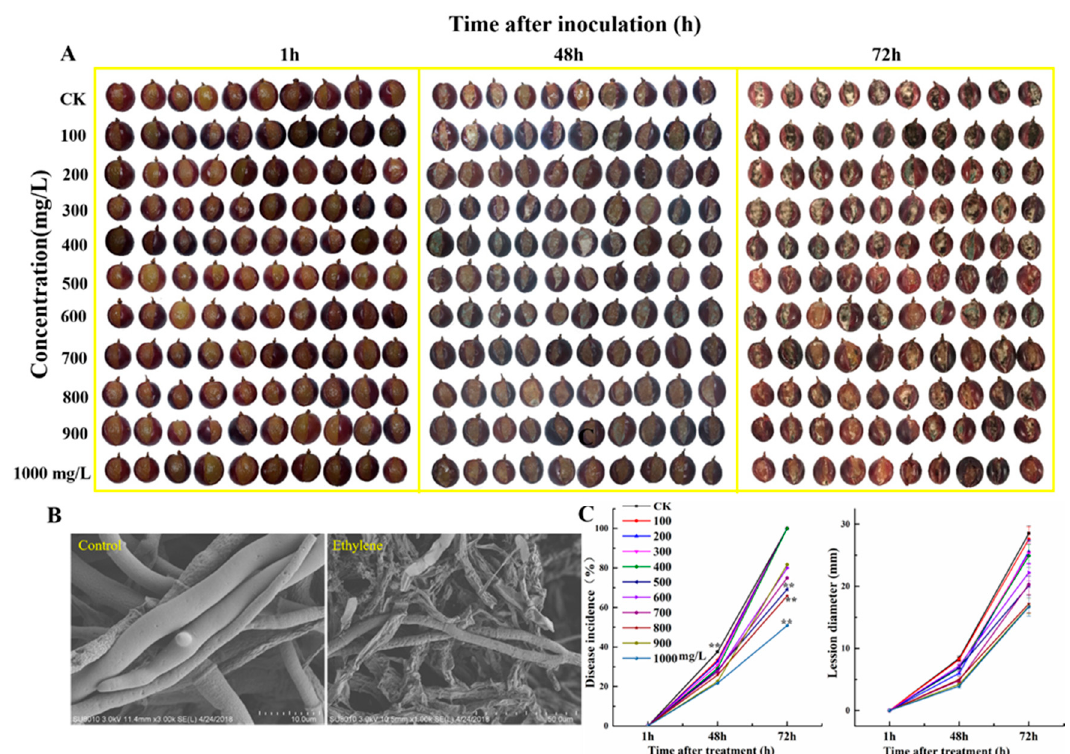
Figure 9. Effects of different concentrations of ethephon pretreatment on the infected grape with B. cinerea . ( A ) The development of B. cinerea on the surface of ‘Kyoho’ grape fruits in pretreated samples with different concentrations of ethephon treatment (100, 200, 300, 400, 500, 600, 700, 800, 900, 1000 mg/L) for 24 h and then inoculation with B. cinerea. Samples were monitored at 1, 48, and 72 h after botrytis infection. ( B ) The B. cinerea mycelium grew on the surface of the grape fruit and was observed by electron microscope at 72 h. ( C ) Fruit disease incidence and lesion diameter changes were calculated. Values are means ± SD of twenty biological replicates. ** Significant differences compared with the control (water-treated fruits) sample at p < 0.01, using Student’s test.